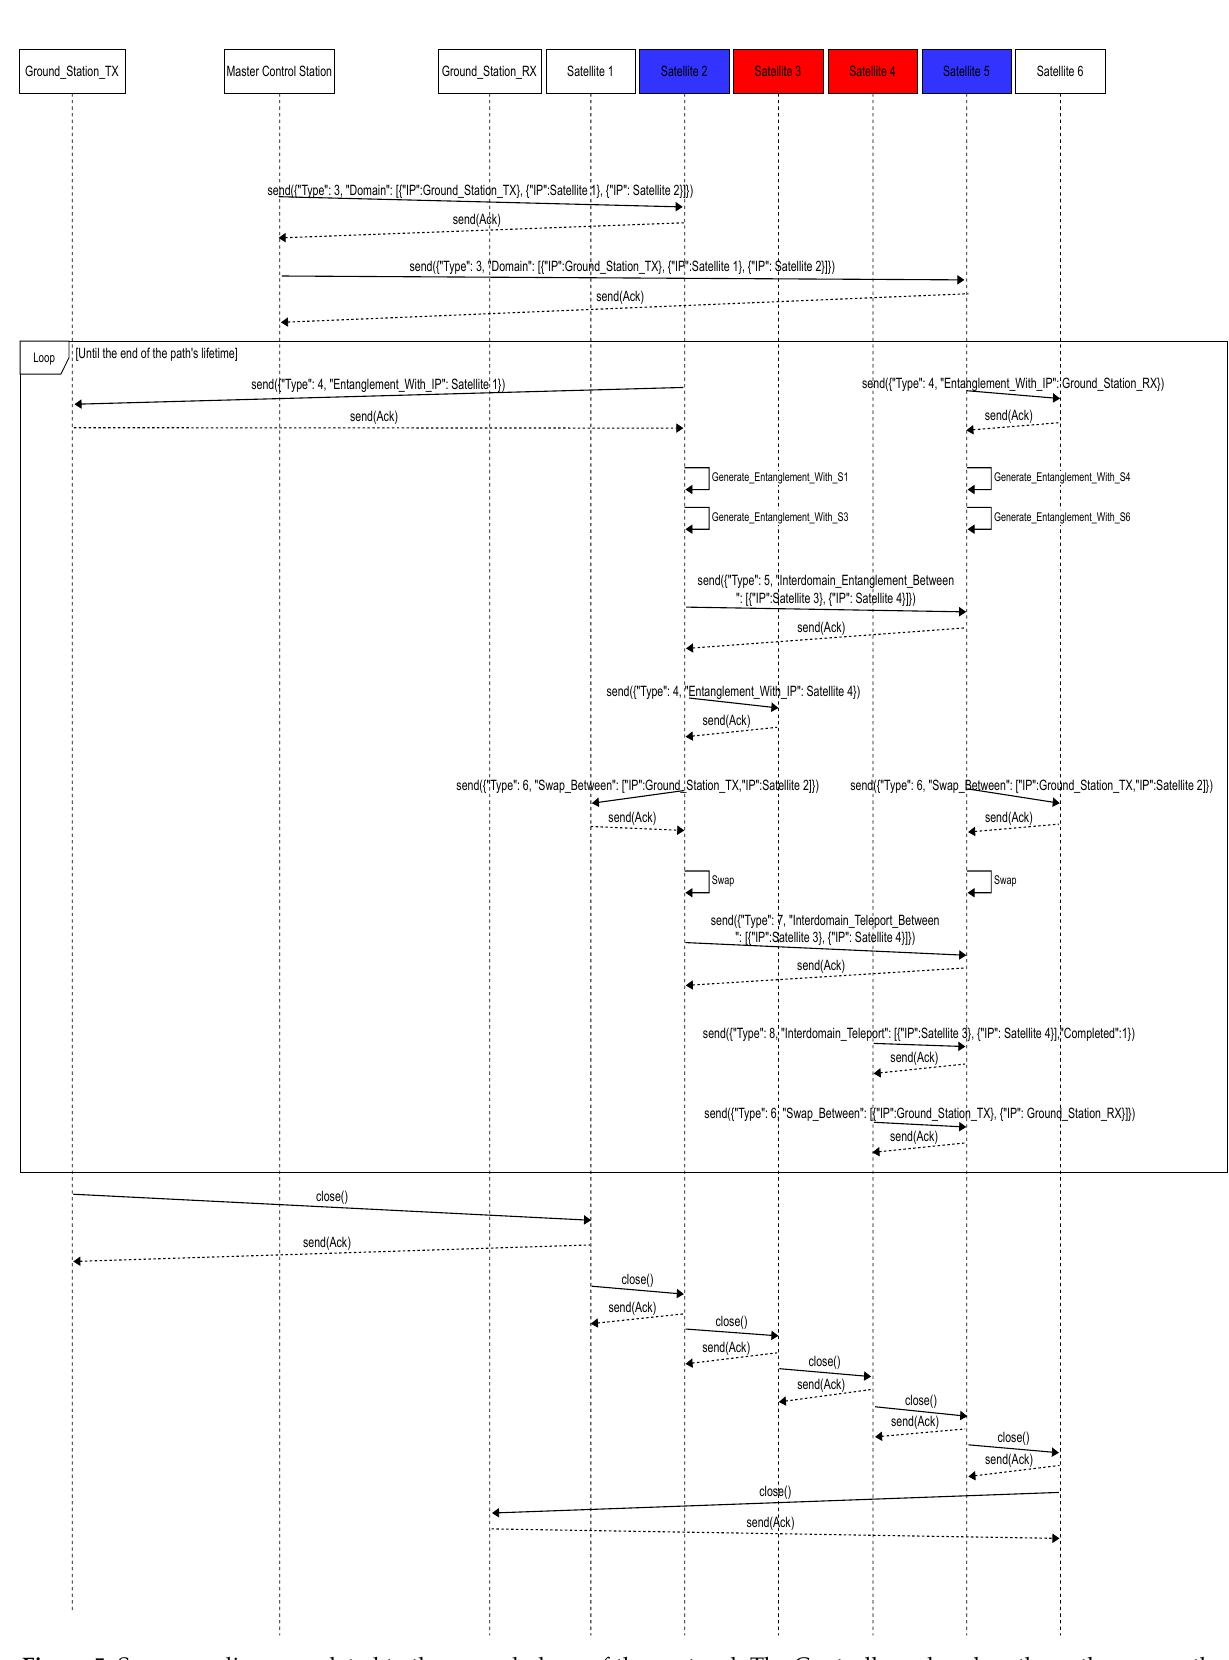
Figure 5. Sequence diagram related to the second phase of the protocol. The Controllers placed on the path manage the entanglement generation and swapping